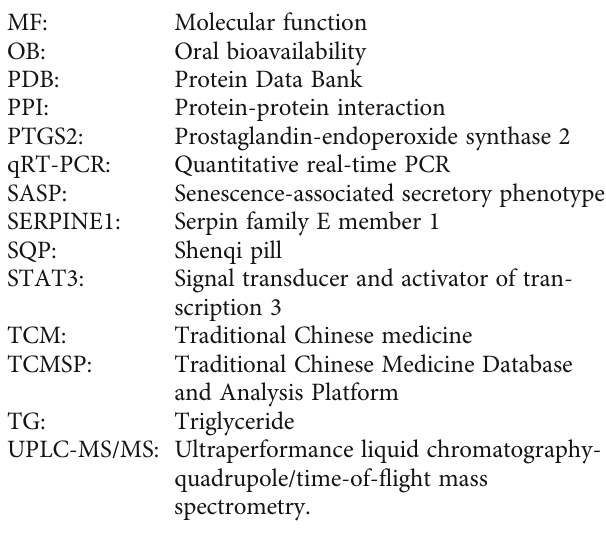
Supplementary Table 1: the information of selected SQP active compounds. (Supplementary